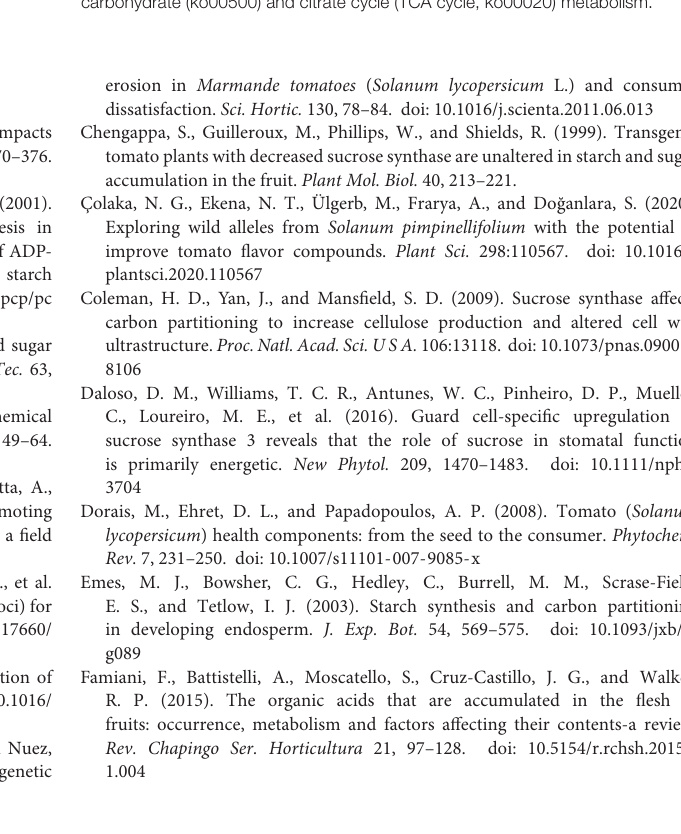
Supplementary Table 2 | Sequence of primers used for qRT-PCR